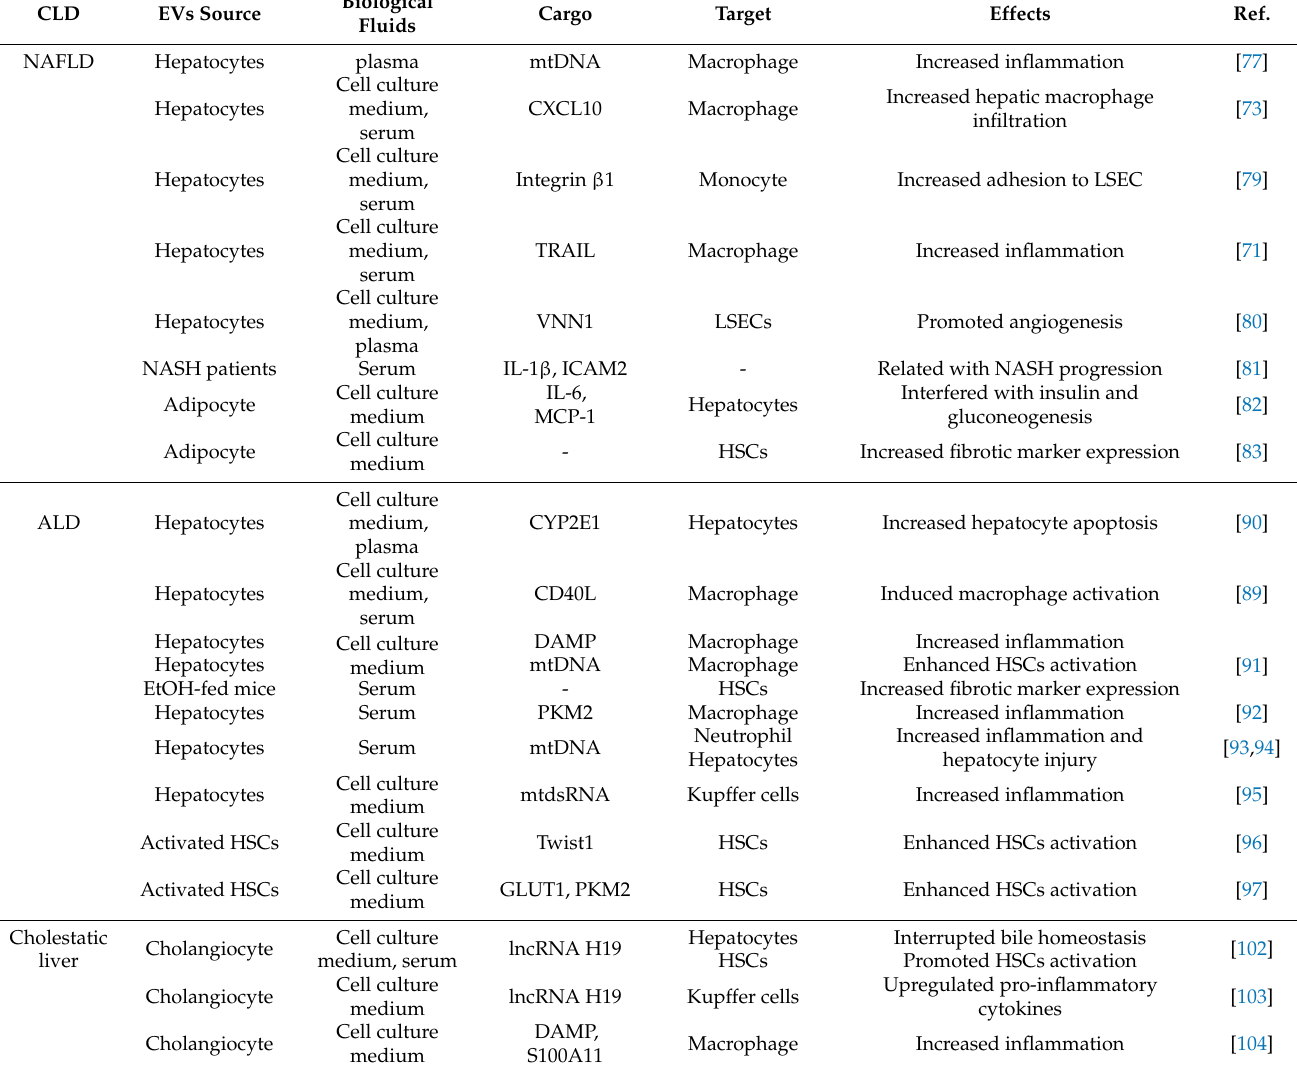
Table 2. Summary of EVs and their cargoes associated with progression of